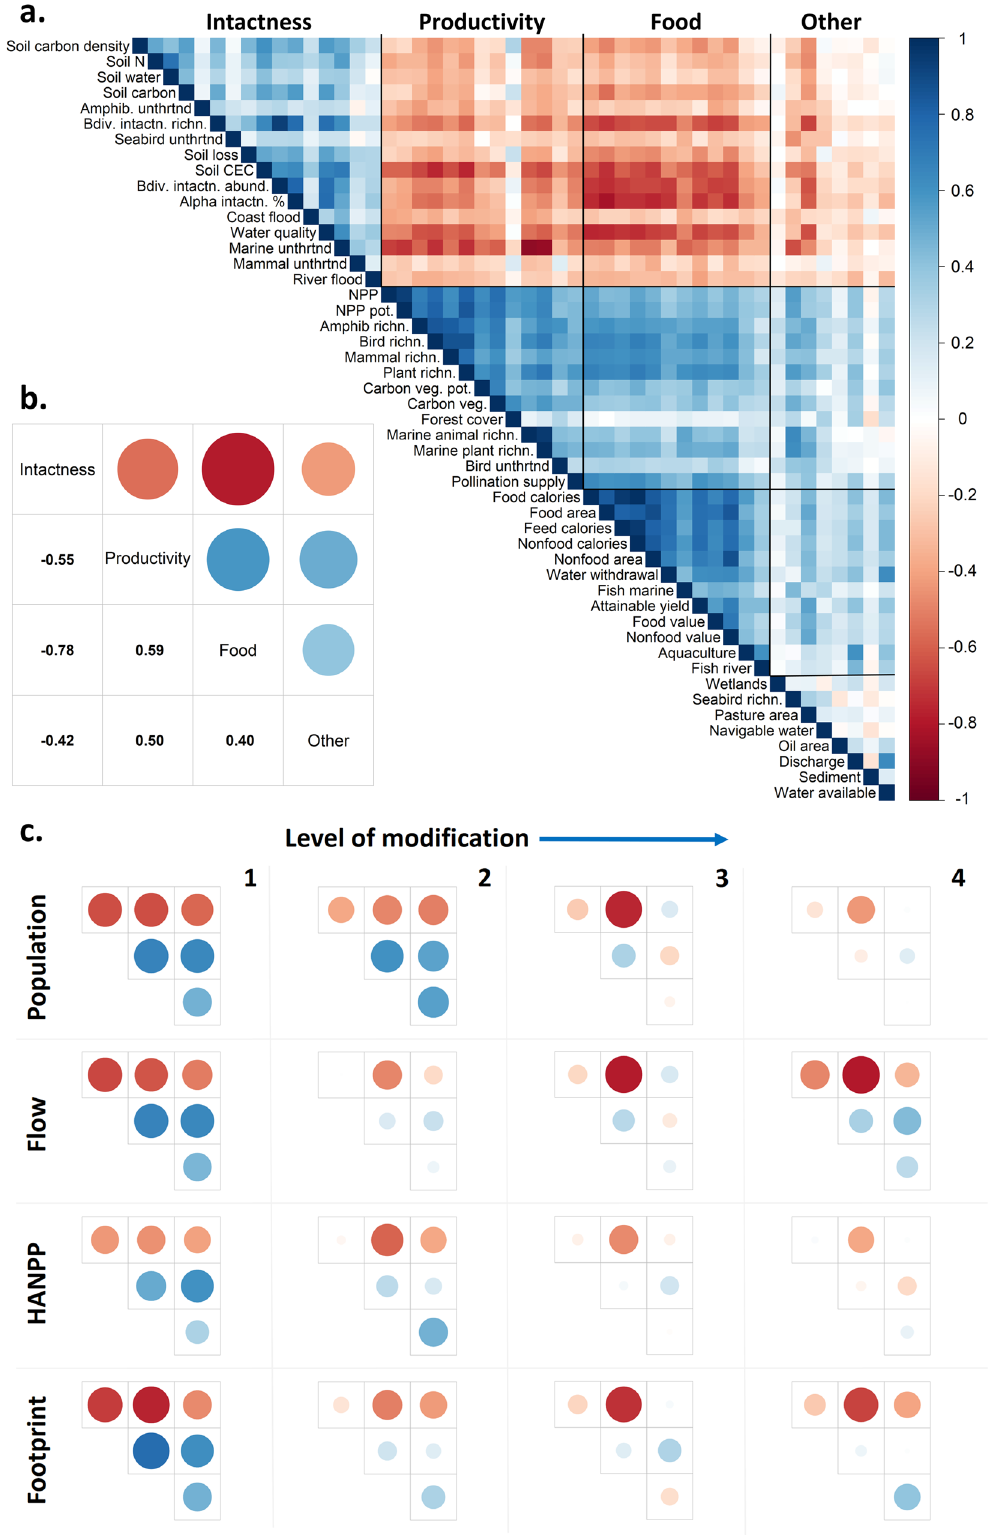
Fig. 3 Correlations between individual and bundled ecosystem services across delta systems. Pairwise correlation (Spearman ’ s ρ ) between each ecosystem service across all deltas ( a ), the ecosystem service bundles across all deltas ( b ), and ecosystem service bundles in deltas at different stages of each modi fi cation indicator ( c , bundles ordered as in b ). The deltas were divided into four stages of modi fi cation using breakpoint analysis. Colour darkness and circle diameter are proportional to the correlation coef fi cient. Blue indicates synergies, red indicates trade-offs. See Supplementary Note 10 for correlation coef fi cients of c